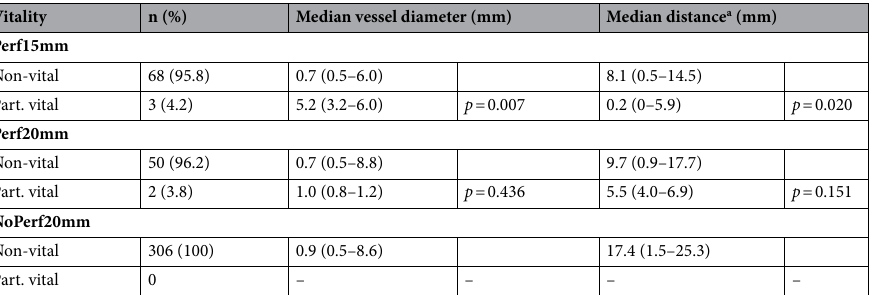
Table 1. Histological vitality around all vessels with a diameter of ≥ 0.5 mm situated within the white zone in dependence of vessel diameter and vessel distance to the ablation center a . Due to a larger ablation area compared to the ablation settings with preserved hepatic perfusion, a greater number of vessels (306/424) could be identified within the WZ when a Pringle maneuver was performed (NoPerf20mm).